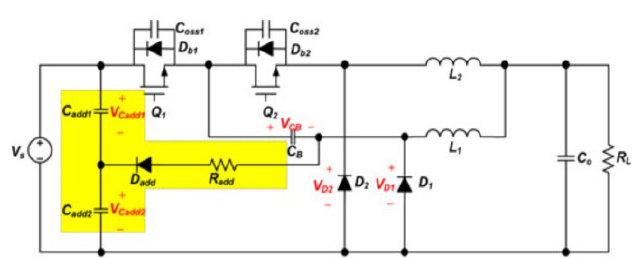
Fig. 12. IBC with extended duty cycle and auxiliary circuit